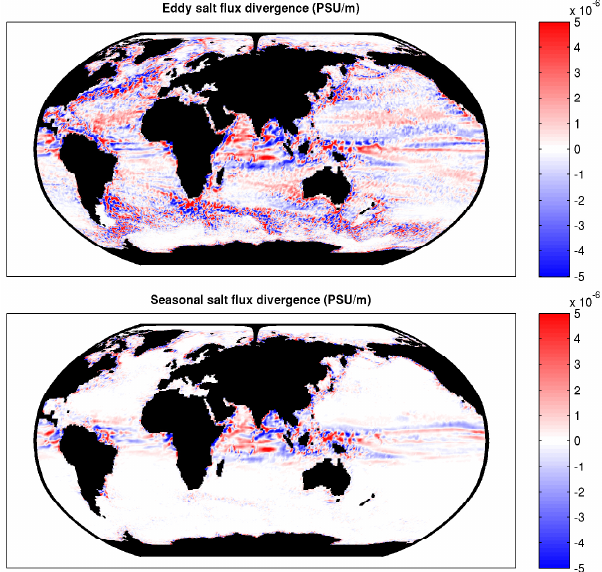
Fig. 7. Divergence of the eddy salt transport in the ORCA12 sim- ulation, computed for 12 × 12 grid point boxes to enhance read- ability. It is integrated vertically and thus expressed in units of PSUms − 1 . The colour scale is saturated in the red and blue at 5 × 10 − 6 PSUms − 1 (the maxima and minima of the field are about 40 times larger). Top panel: total eddy component; bottom panel: seasonal contribution